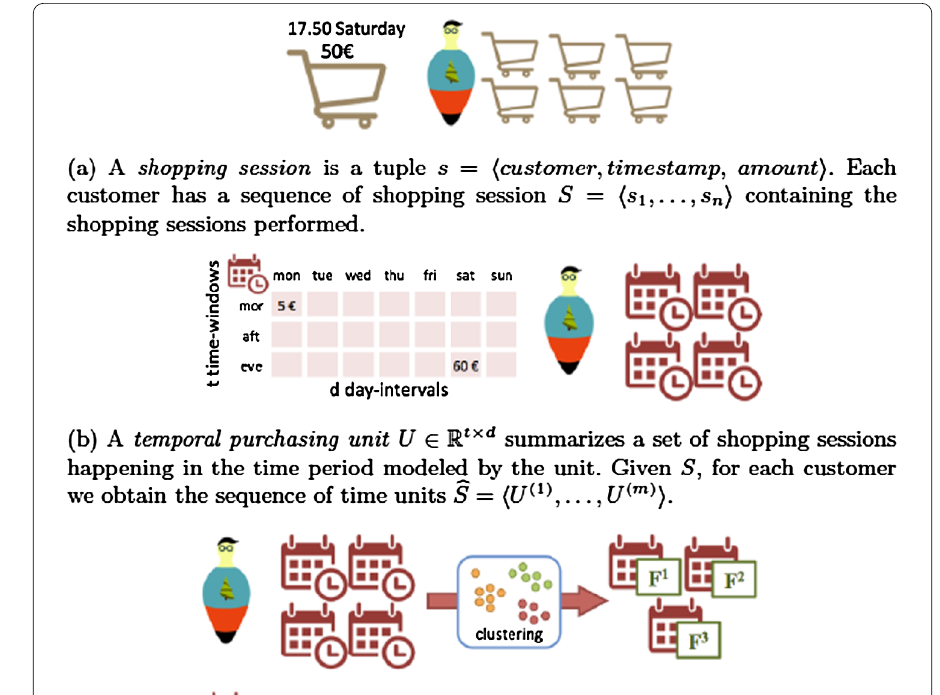
Given customer c , her sequence of temporally ordered shopping sessions S = (cid:2) s 1 ,..., s n (cid:3) , the time window granularity t , the day-interval granularity d , and the width of the time pe- riod τ , then S can be segmented into an ordered sequence of units